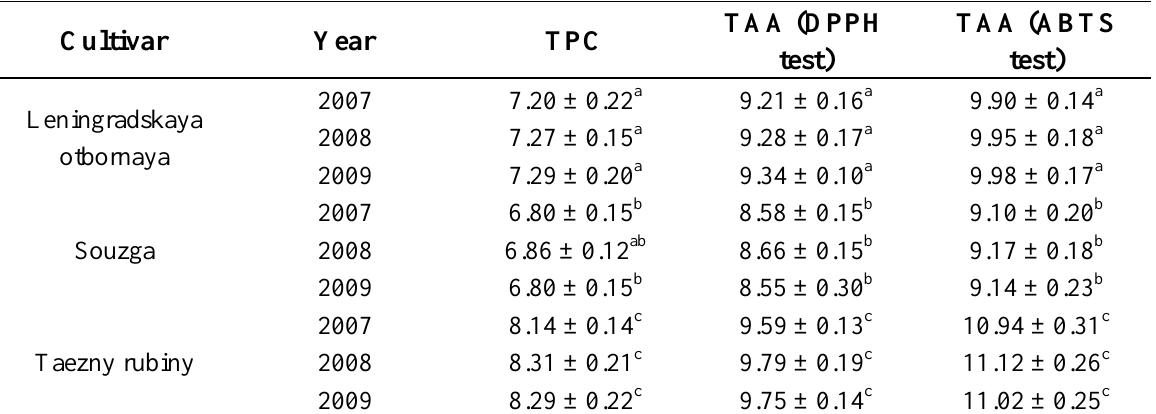
Table 3. Total phenolic content (grams of gallic acid/kg FM) and antioxidant activity (grams of AAE/kg FM) of fruits of different cultivars of European cranberrybush ( Viburnum opulus var. edule Marsh.), n = 25.